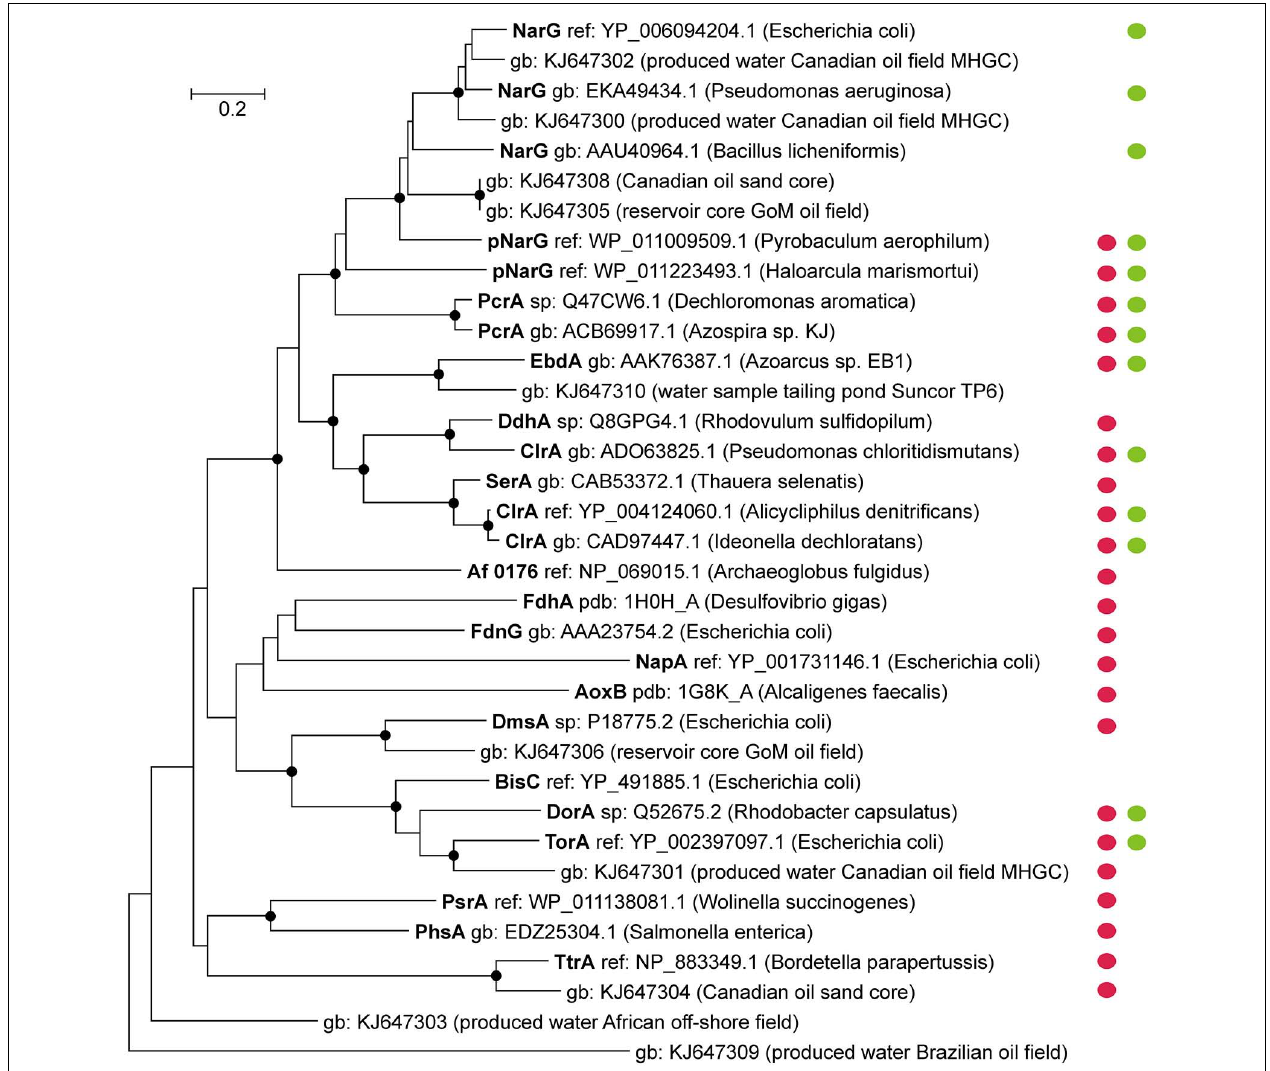
FIGURE 2 | Diversity of catalytic subunits of selected DMSO Mo-enzymes. Protein sequences of characterized and functionally active enzymes and partial sequences retrieved from metagenomic datasets of oil reservoir environments are displayed; red circles mark the periplasmic location of the catalytic subunit, whereas green circles indicate activity with chlorate (next to the canonical enzyme function). For most of the DMSO enzymes no data are available regarding their activity towards perchlorate.